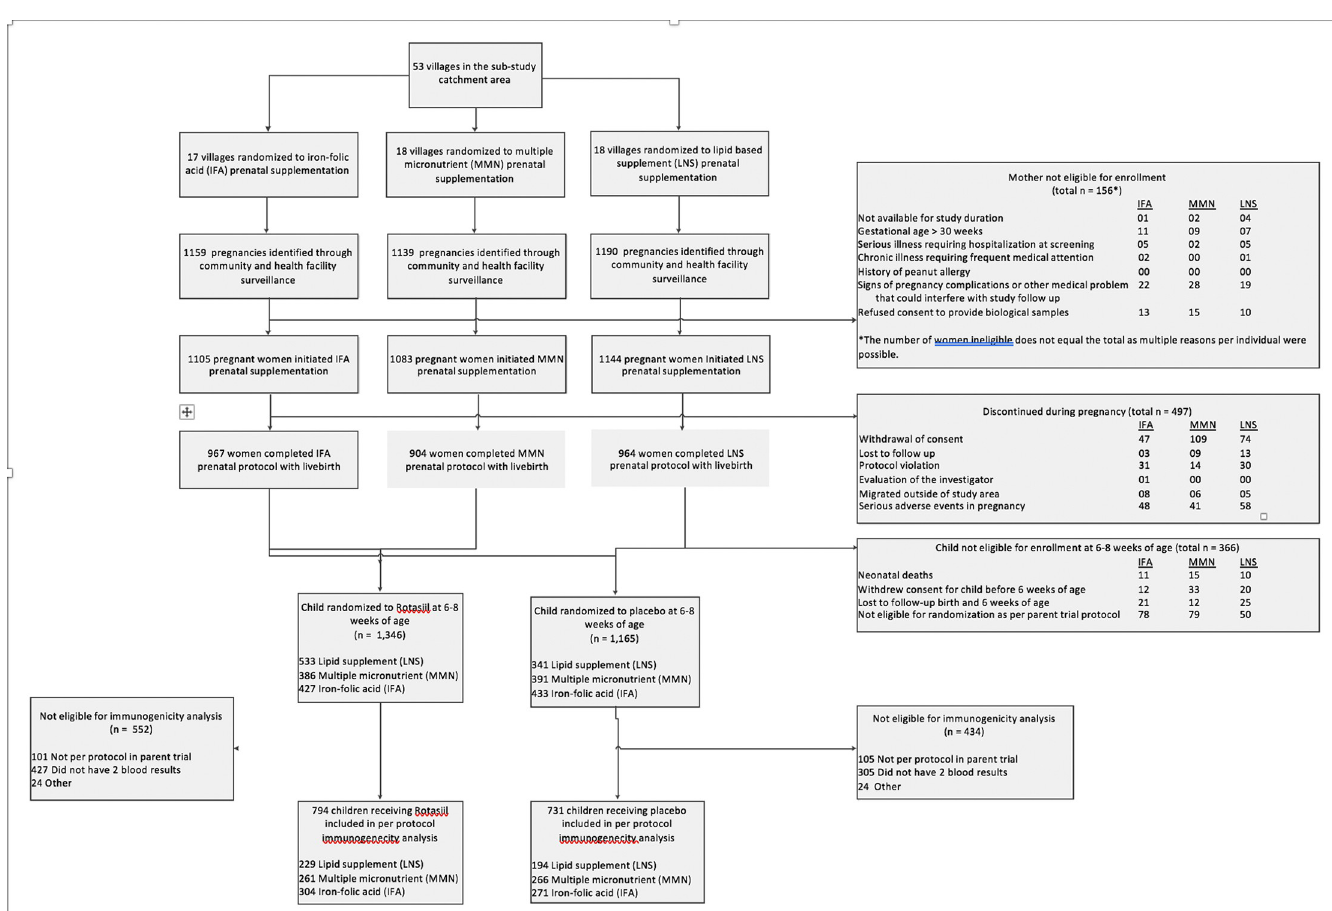
Fig 1. Flowchart of study participants. I AU : AbbreviationlistshavebeencompiledforthoseusedthroughoutFig 1 andTables 1 (cid:0) 3 : Pleaseverifythatallentriesarecorrect : FA, iron–folic acid; LNS, lipid-based nutrient supplement; MMN, multiple micronutrients.